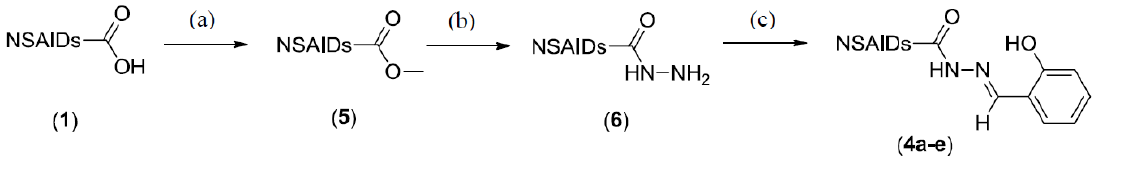
NH 64%, CH OH, r.t. (90%–95%); (c) salycilic aldehyde, ethanol, 2 2 3